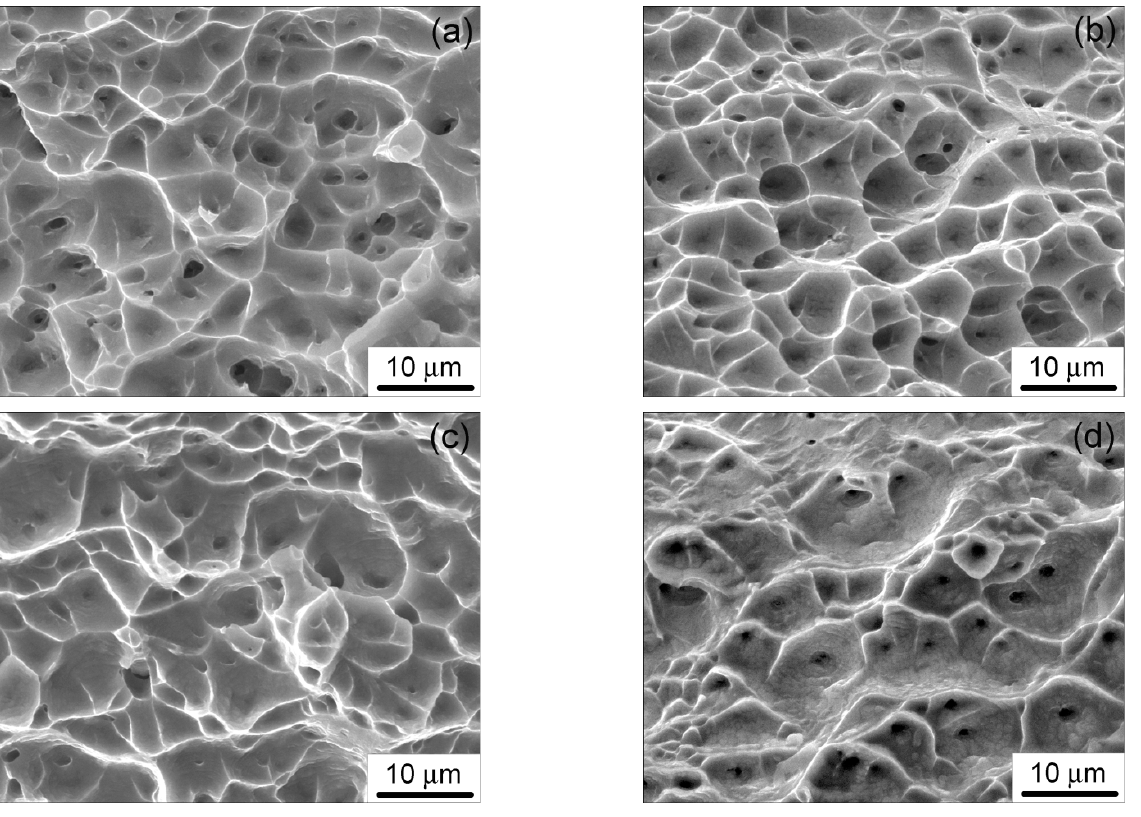
Figure 8. Fracture surface of the titanium alloys after creep at 723 K: ( a ) FG and ( b ) UFG Ti-2.9Al-4.5V-4.8Mo-0.15H; ( c ) FG and ( d ) UFG Ti-2.9Al-4.5V-4.8Mo.